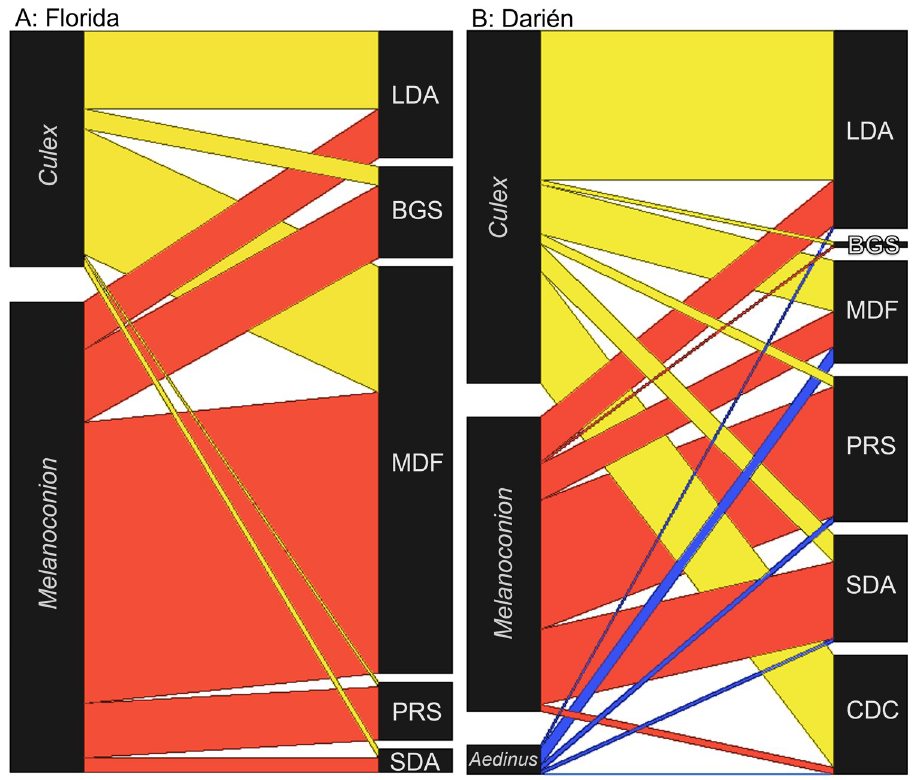
Fig 5. Bipartite analysis of the subgenera of Culex collected by each trap type. Proportions of major subgenera Culex (yellow), Melanoconion (red), and Aedinus (blue) captured by five of the large-diameter aspirator (LDA), BG-Sentinel (BGS), CDC miniature light trap (CDC) (shown for Panama only), mosquito drift fence (MDF), pop-up resting shelter (PRS), and the small-diameter aspirator (SDA) (excluding the CDC trap in Florida only) are depicted for Florida City, FL (A), and Darie´n, Panama collections (B).